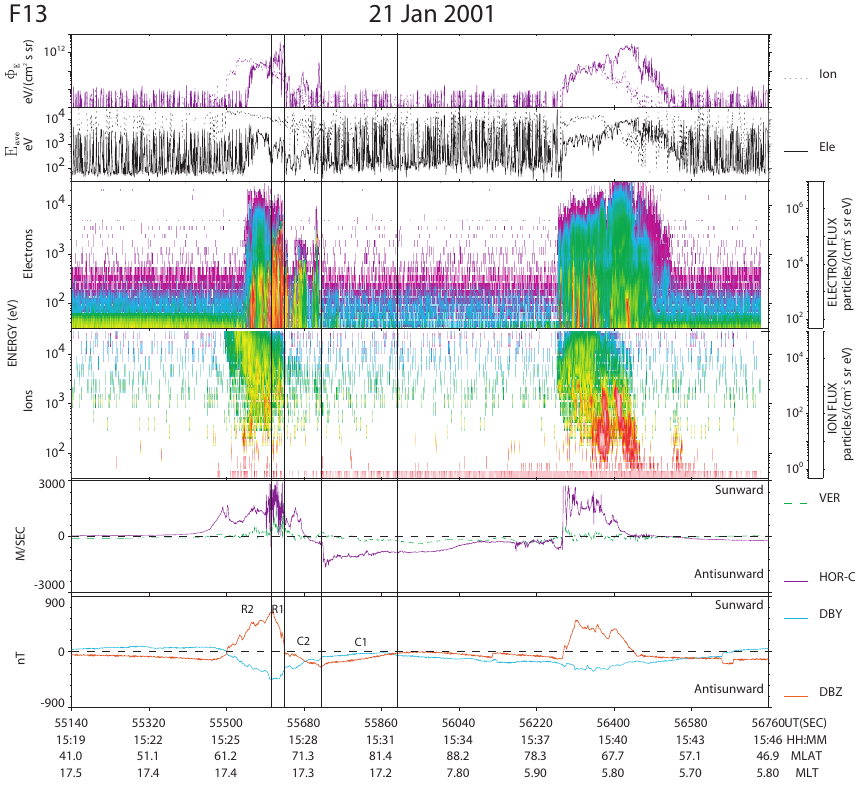
Fig. 6. DMSP F13 data for the dusk - dawn pass during the interval 15:19–15:46 UT on 21 Januray 2001. Same format as in Fig. 5. The bottom panel shows the horizontal magnetic deflection components B x (red; east-west) and B y (blue; along the track). Intervals representing different FAC regimes (R2-R1-C2-C1) and auroral precipitation regimes are marked by vertical guidelines.